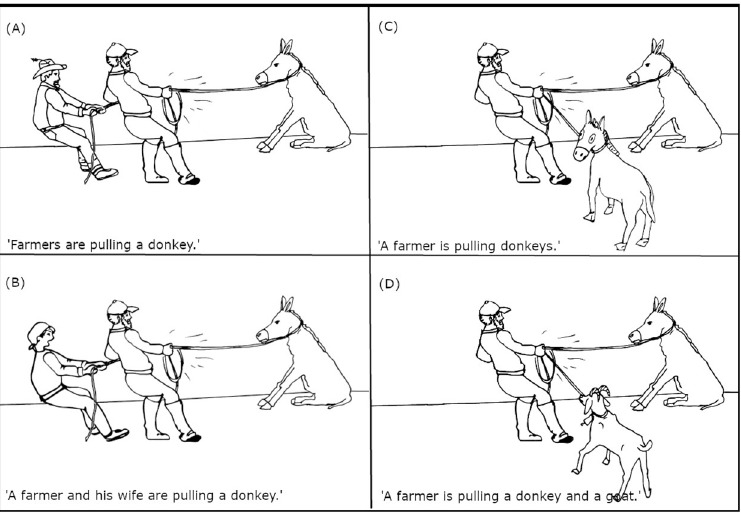
Fig 2. An example picture in four experimental conditions eliciting short and long sentences.